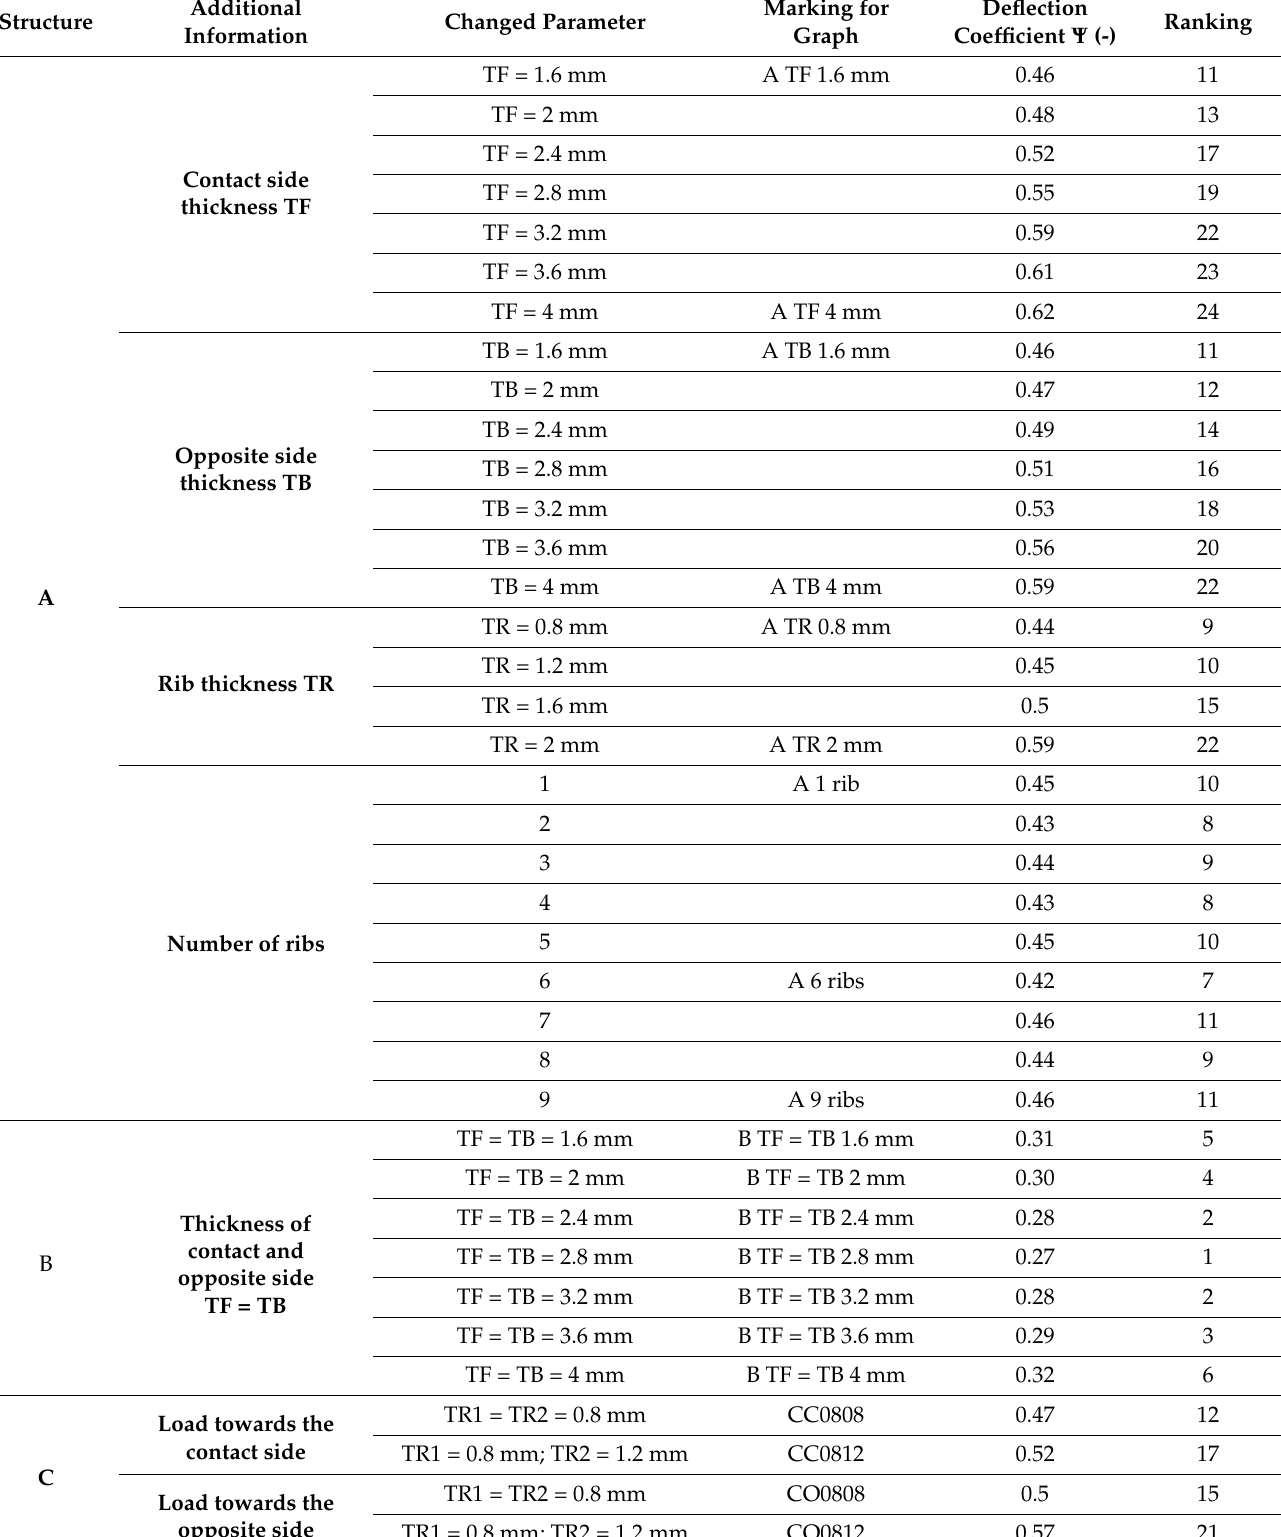
Table 3. Deflection coefficient for testing